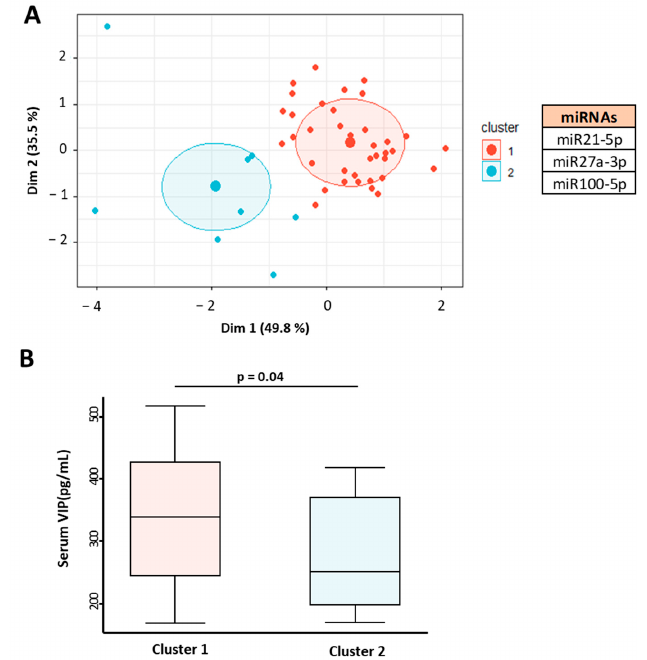
Figure 4. Association of miRNA profile in patients with immune-mediated inflammatory diseases (IMID) with serum levels of VIP. ( A ) Graphical representation of cluster analysis based on miR215p, miR27a-5p, and miR100-5p expression in 45 IMID patients. K-means clustering based on Euclidean distance and principal component analysis (PCA) was applied. ( B ) Serum VIP levels (pg/mL) of IMID patients according to their association with miRNA expression cluster. Statistical significance was calculated using the variable of serum VIP levels normalized by inverse square root and applying Student’s t -test. Data are presented as the interquartile range (p75: upper edge of the box, p25: bottom edge of the box, and p50: midline) and p90 and p10 (lines below and above the box) of the serum VIP levels. Significance threshold was set at p <